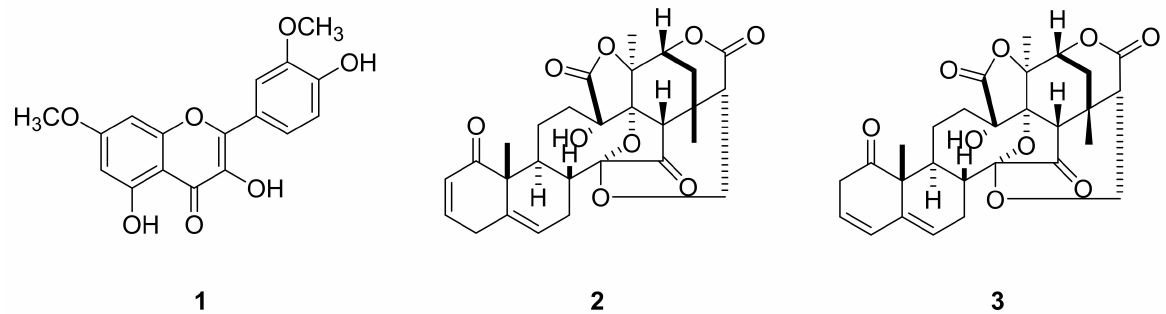
Figure 1. Structures of compounds 1–3 isolated from P. alkekengi var. franchetii , 3 (cid:48) ,7-dimethylquercetin ( 1 ), physalin B ( 2 ), and isophysalin B ( 3